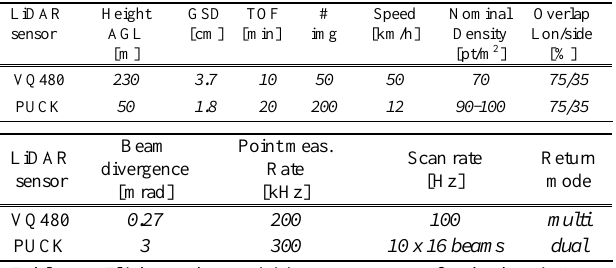
Table 1: Flight and acquisition parameters for both